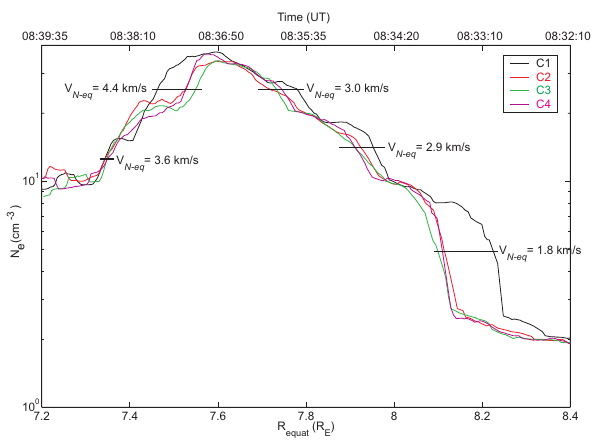
Fig. 3. Electron density profiles for the four CLUSTER satellites as a function of R equat across the plume observed on 7 May 2002 (time indicated as reference). The magnitude of the normal bound- ary velocity vectors V N − eq derived from the time delays at dif- ferent times during the crossing and projected onto the magnetic equatorial plane is indicated on the